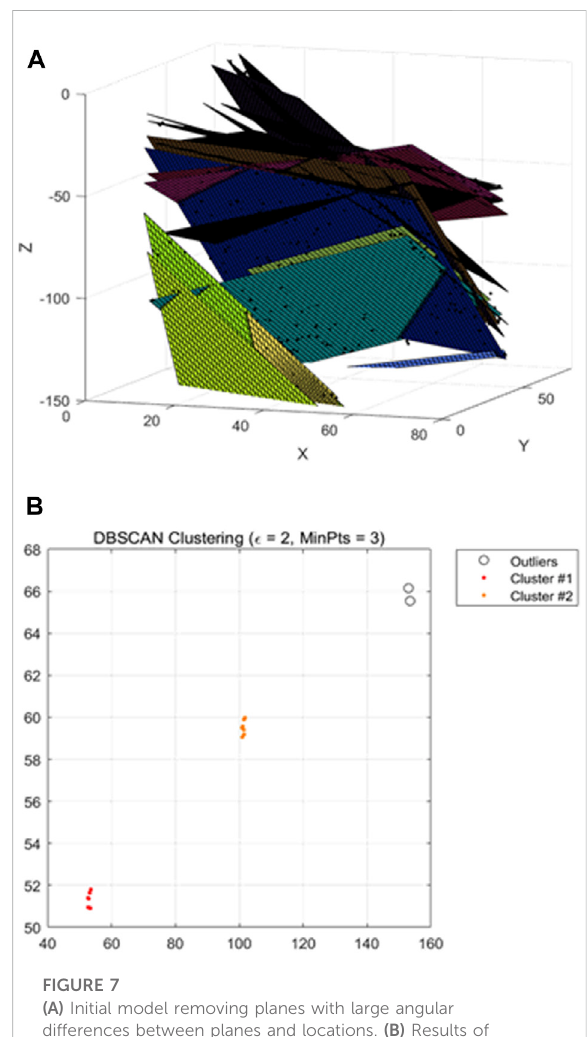
FIGURE 7 (A) Initial model removing planes with large angular differences between planes and locations. (B) Results of orientation clustering after energy